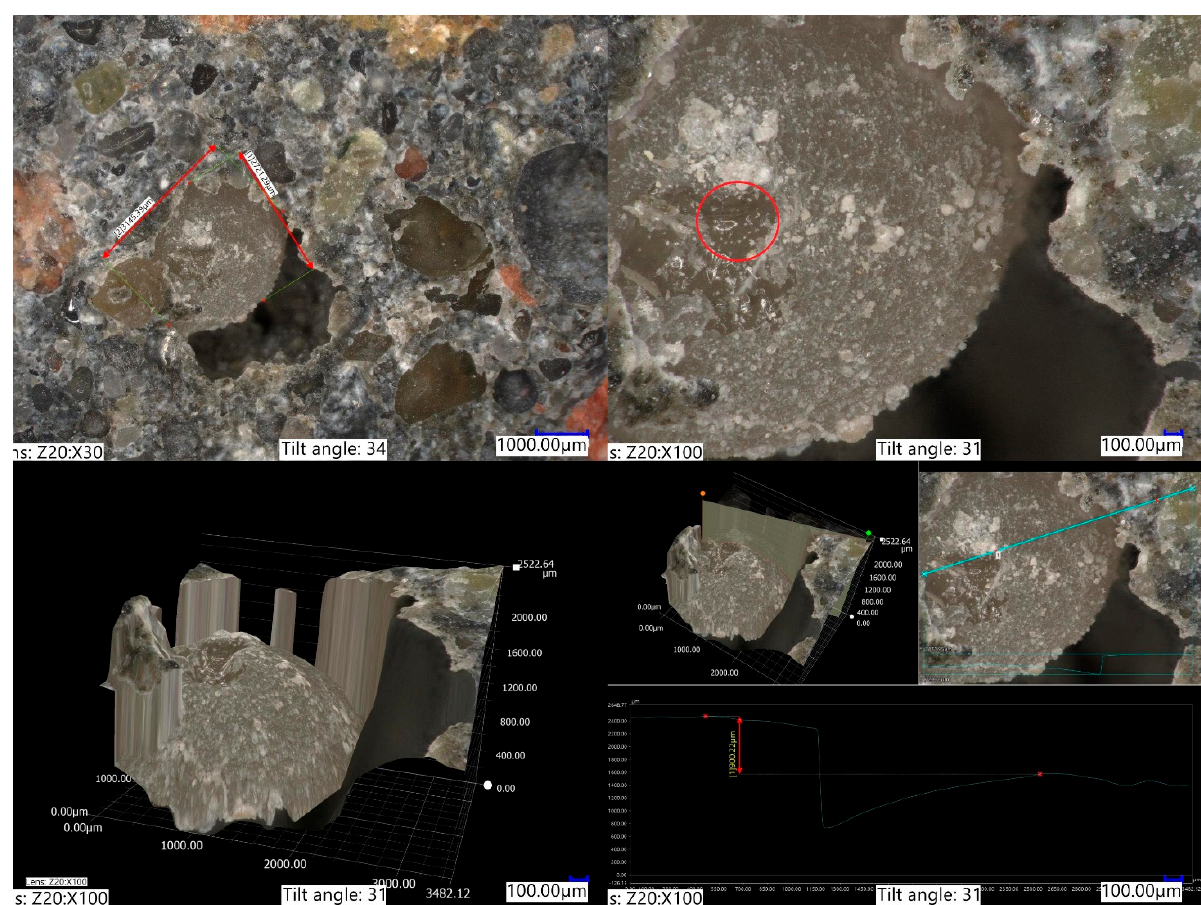
Figure 7. Micrograph of SAP B particle of spherical morphology in SAP BD5 concrete series after exposure to 3% NaCl environment. Red-circled is a fragment of SAP B with a removed outer layer of crystallized NaCl showing a lack of visible salt crystallization within saturated SAP B.